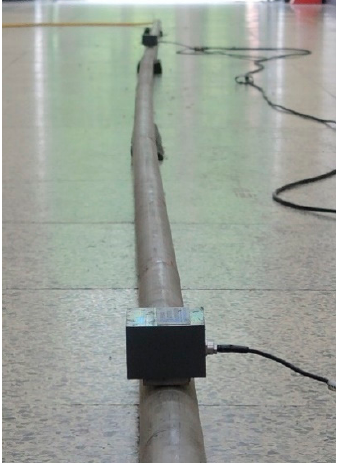
Figure 8. An impulse hammer.